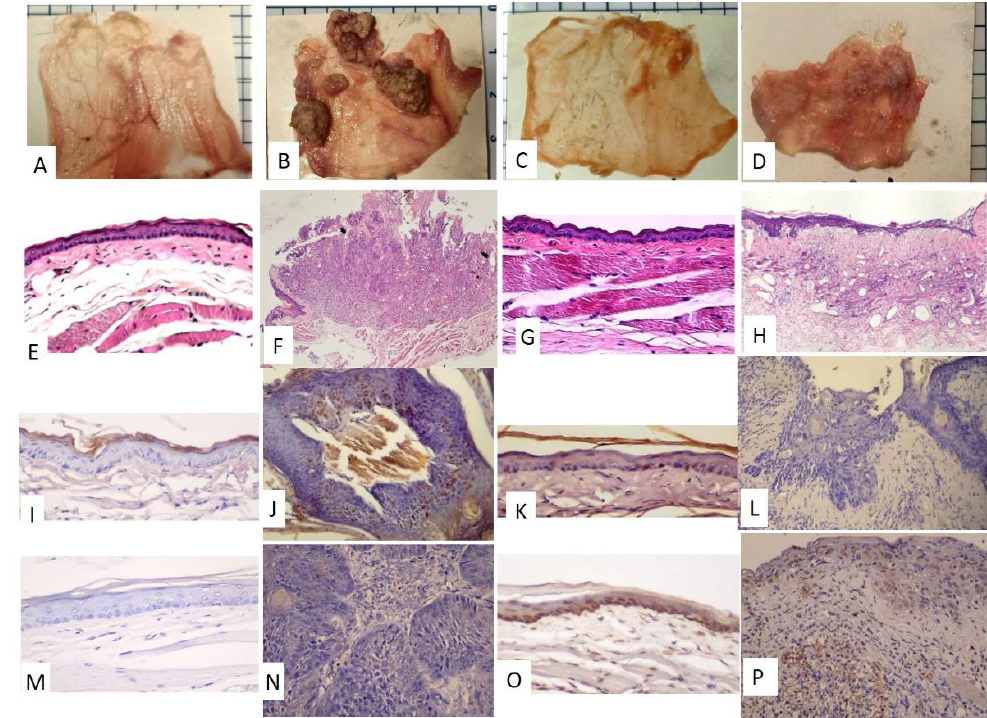
Figure 2. Gross examination of the pouch specimens, HE staining, p53 staining, and TUNEL staining. ( A – D ) Pouch specimens (scale bar: 5 mm – the blue line spacing on the margin of the photo) ( A , E , I , M ): PreC; ( B , F , J , N ): PreD; ( C , G , K , O ): PostC; ( D , H , L , P ): PostD. ( E – H ), HE staining, ( E , G ): 100×; ( F , H ): 40×. ( I – L ), p53 staining, 200×, ( I , L ): negative; ( J , K ): partially positive ( M – P) , TUNEL staining, 200×. ( M , N ): negative, ( O , P ): positive.